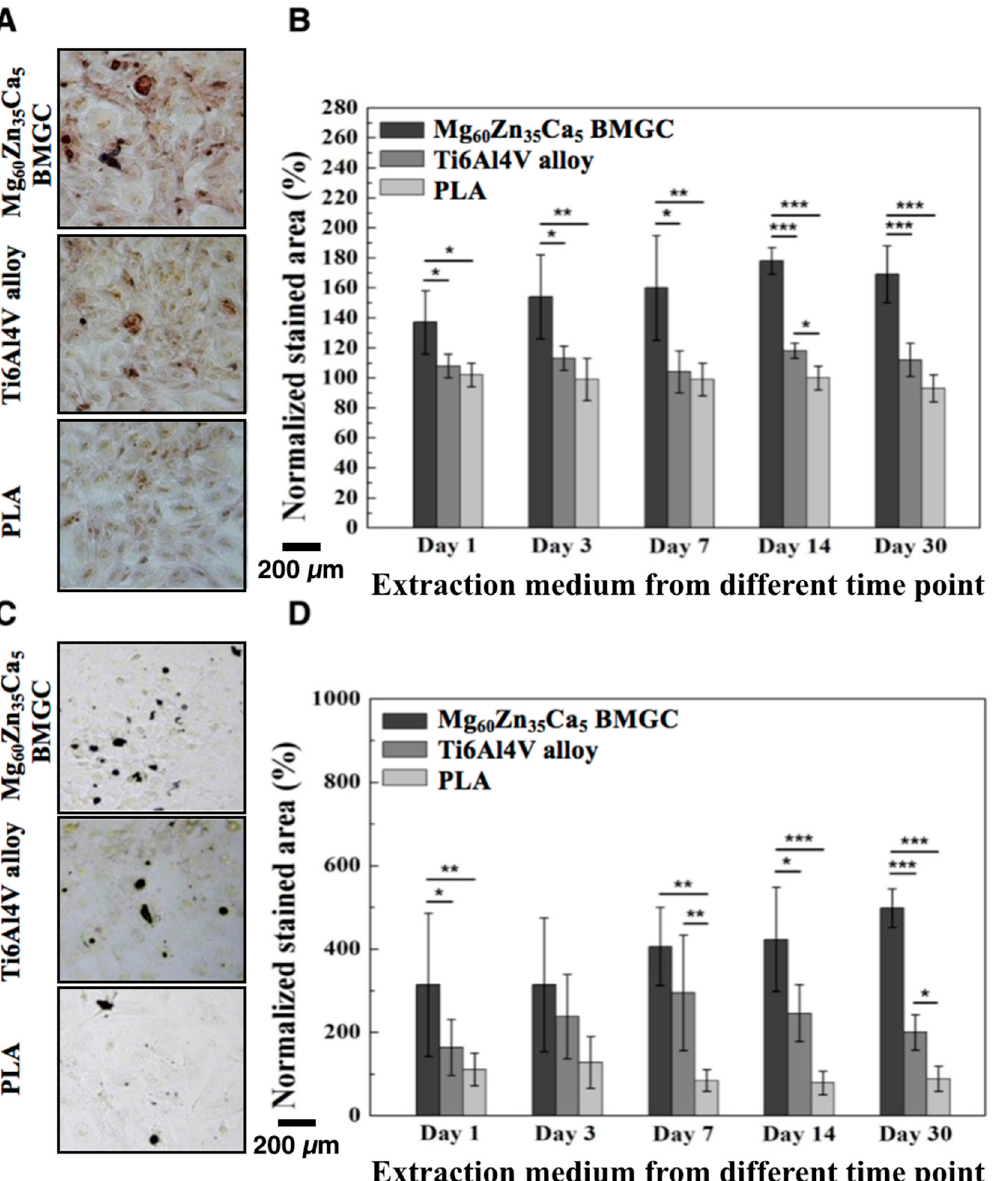
Figure 3. Extracellular calcium and mineral deposition by rabbit osteoblasts under treatment with di ff erent extraction medium. ( A ) Image of alizarin red S staining. ( B ) Quantitation of calcification of the extracellular matrix of primary rabbit osteoblasts cultured in di ff erent extraction medium for di ff erent time periods that stained by alizarin red S staining. ( C ) Image of von Kossa staining. ( D ) Quantitation of mineralization of primary rabbit osteoblasts cultured in di ff erent extraction medium for di ff erent time periods that stained by von Kossa staining. (Data normalized with control group: without extraction medium; * p < 0.05, ** p < 0.01, *** p < 0.001.)